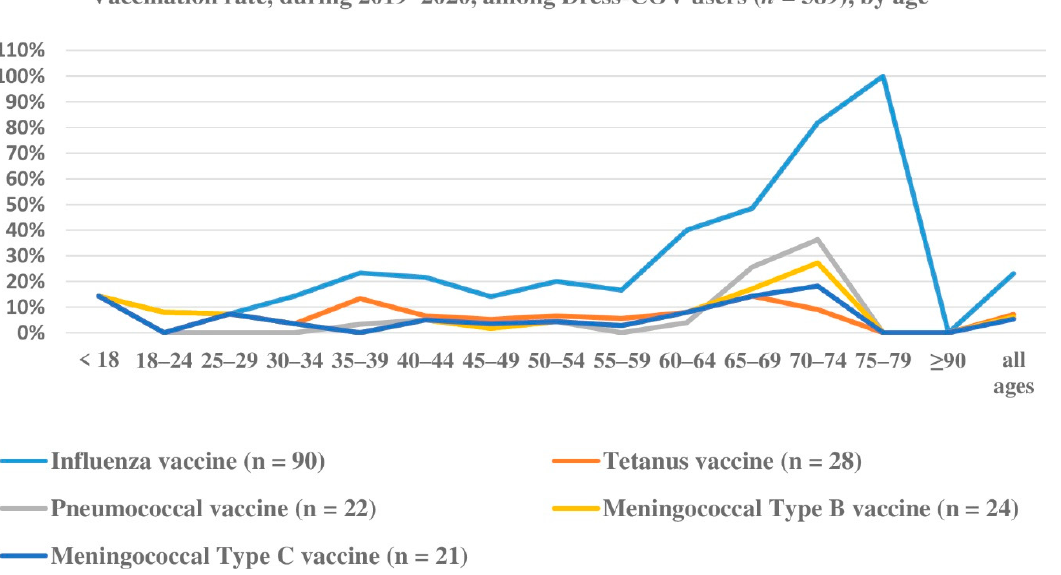
Figure 9. Dress-COV: vaccination rate (2019–2020) by age and type of vaccine.